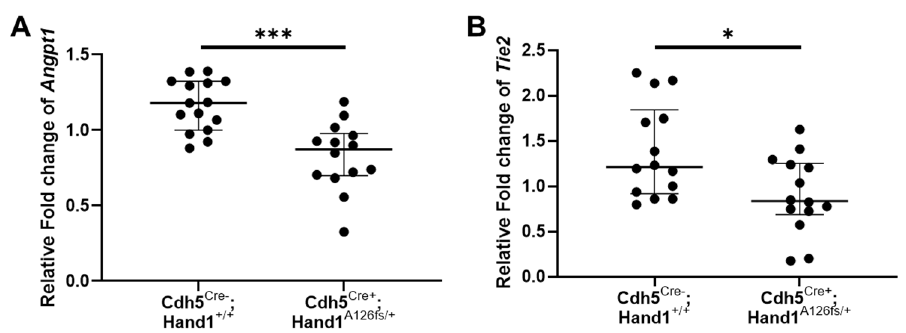
Figure 9. Analysis of angiogenic factor Angiopoietin 1 ( Angpt1 ) and Angpt1 Receptor ( Tie2 ) mRNA expression in wildtype ( Cdh5 Cre − ;Hand1 +/+ ) and Cdh5 Cre+ ;Hand1 A126fs/+ placentas at embryonic day 16.5 . mRNA expression of both Angpt1 ( A ) and Tie2 ( B ) was reduced in the Cdh5 Cre+ ;Hand1 A126fs/+ placentas compared to wildtype. Expression was not different between the fetal sexes for either genotype. Data are median ± interquartile range. Individual dots represent individual placentas. n = 3–6 litters per time point. Statistical significance determined using a Mann–Whitney test. * P < 0.05, *** P < 0.001.